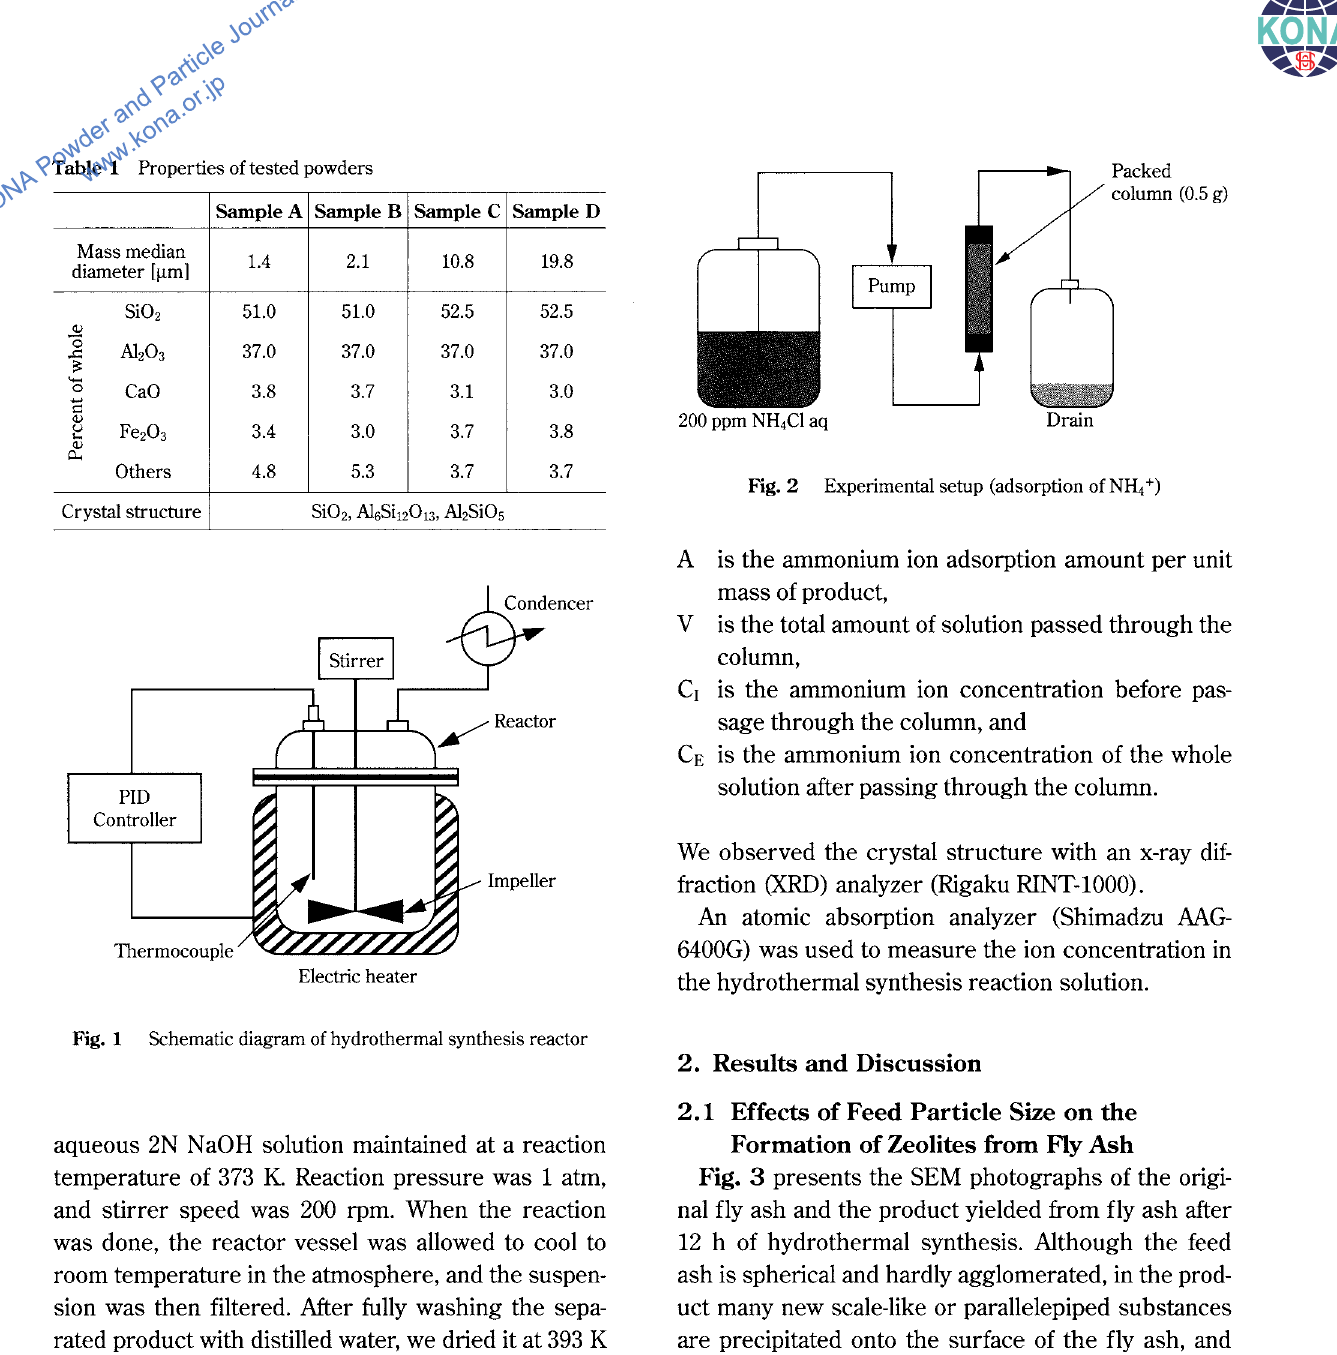
Experimental setup (adsorption of NH 4